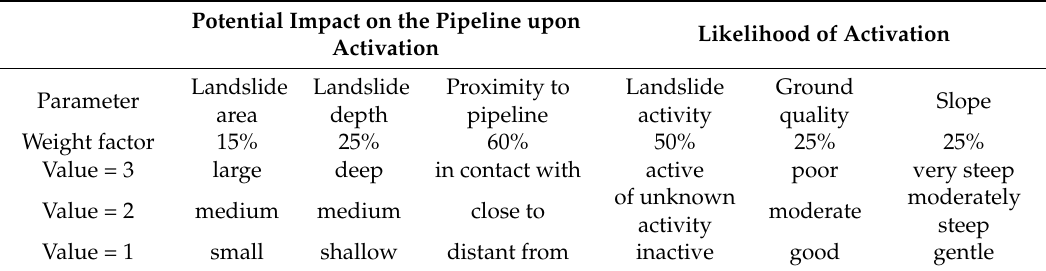
Table 3. Risk assessment scheme, including the six main parameter values and their relative weighting